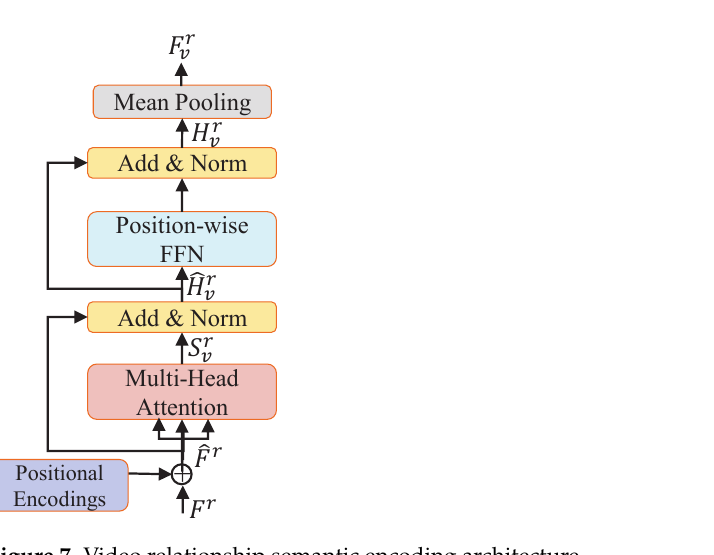
Figure 7. Video relationship semantic encoding